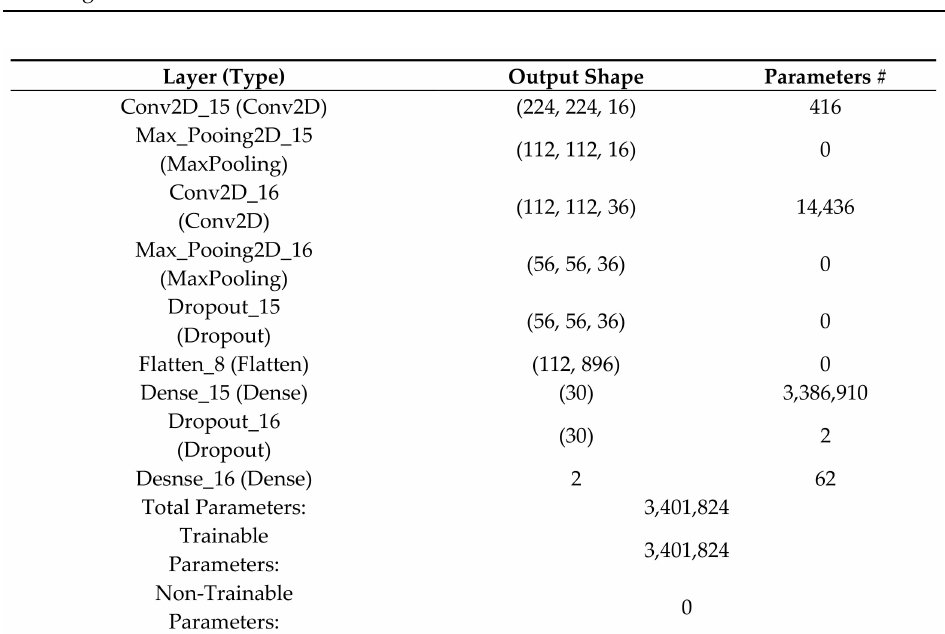
Figure A3. LeNet Layers